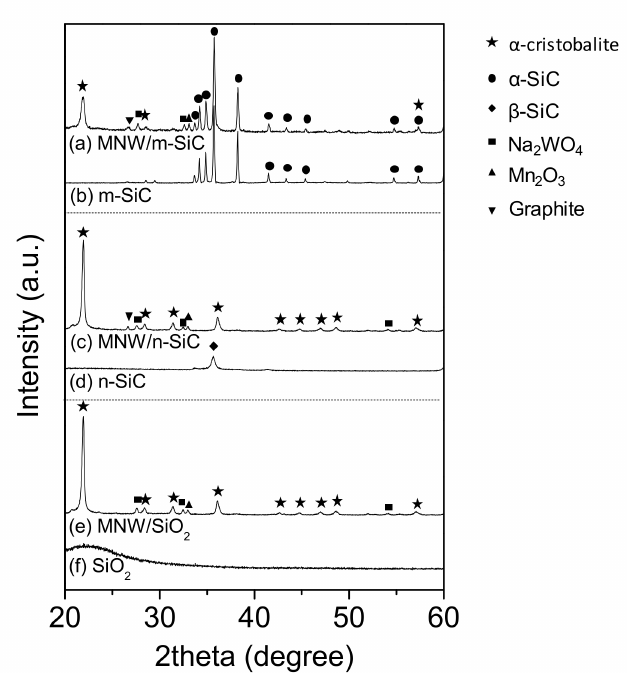
Figure 2. X-ray di ff raction patterns of ( a ) MNW / m-SiC; ( b ) m-SiC; ( c ) MNW / n-SiC; ( d ) n-SiC; ( e ) MNW / SiO 2 ; and ( f ) SiO 2